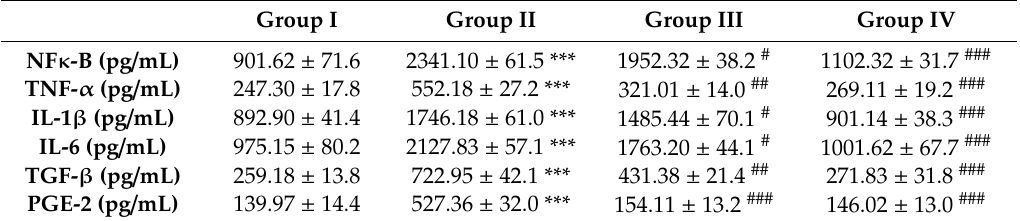
Table 4. Effect of treatment of naringenin on inflammatory markers in different experimental groups. Table 4. E ff ect of treatment of naringenin on inflammatory markers in di ff erent experimental groups. Group I Group I Group II Group III Group IV NF κ -B (pg / mL)